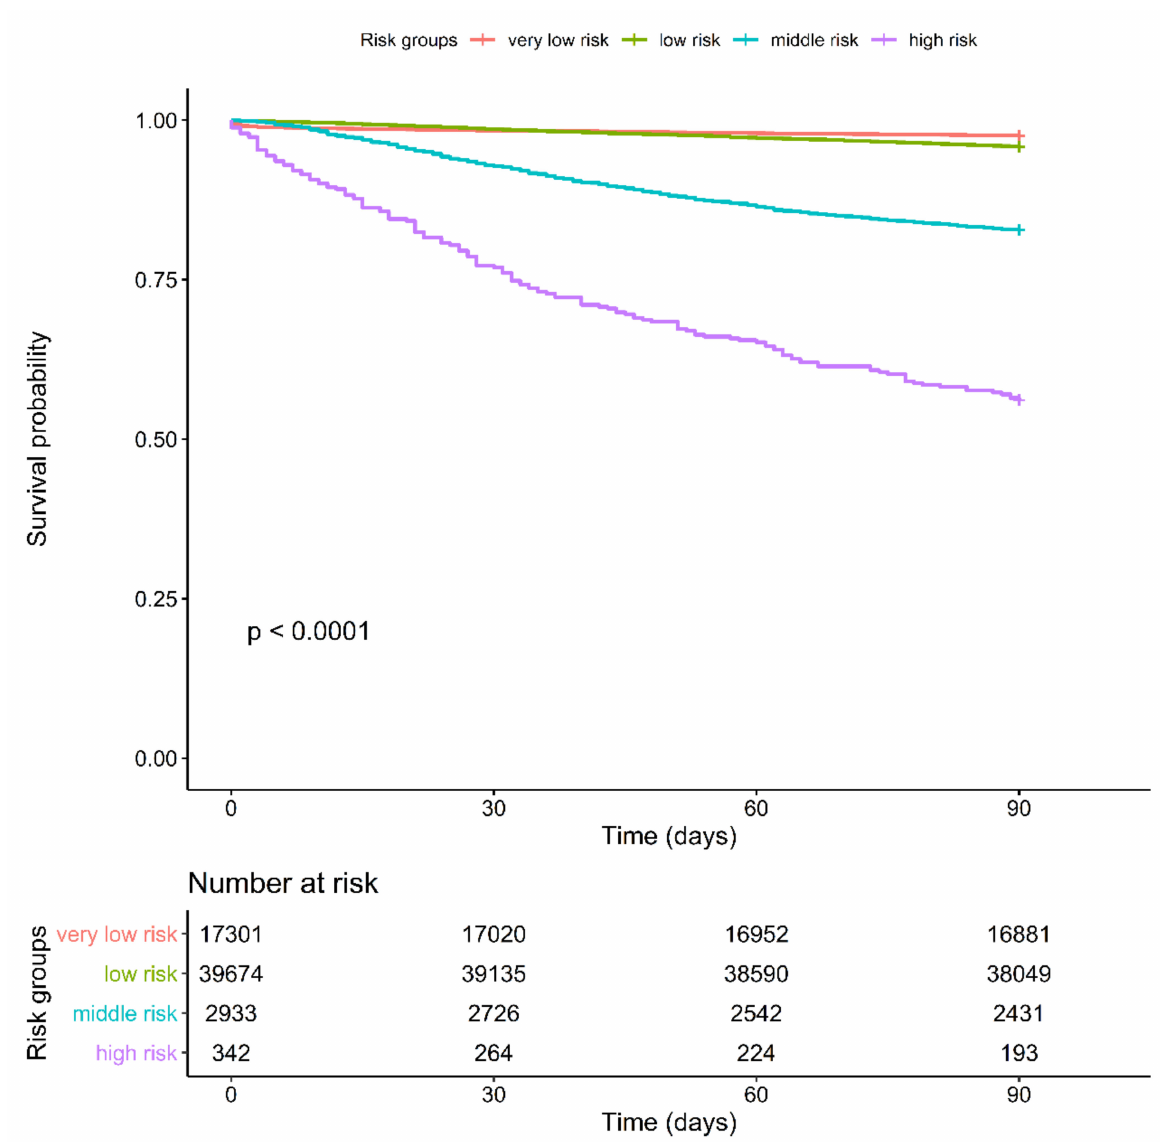
Figure 1. Kaplan–Meier Survival Curve for 90-Day Mortality for Four Chang Gung-PohAi-Major Hepatectomy Mortality Predictive Scoring System Groups. Note: p value (log-rank test) <0.0001. The Chang Gung-PohAi predictive scoring system predicted not only the perioperative 90-day mortality risk but also the long-term survival outcomes of the four risk groups of the patients undergoing major hepatectomy. Furthermore, the prediction of risks and outcomes by this novel scoring system was more satisfactory than that of the ASA and CCI scoring systems for the patients with HCC undergoing receiving major